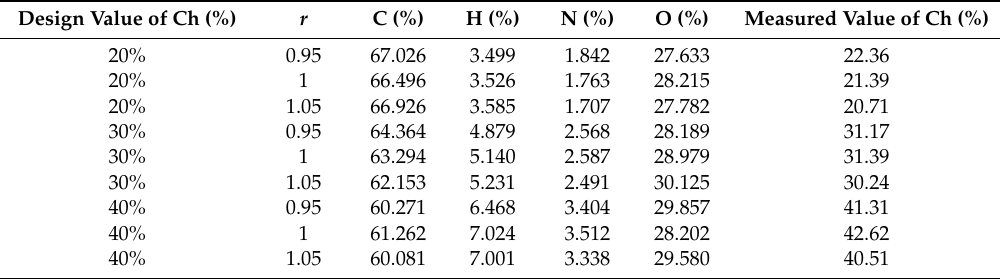
Table 4. Element analysis of polyether-based TPUs.